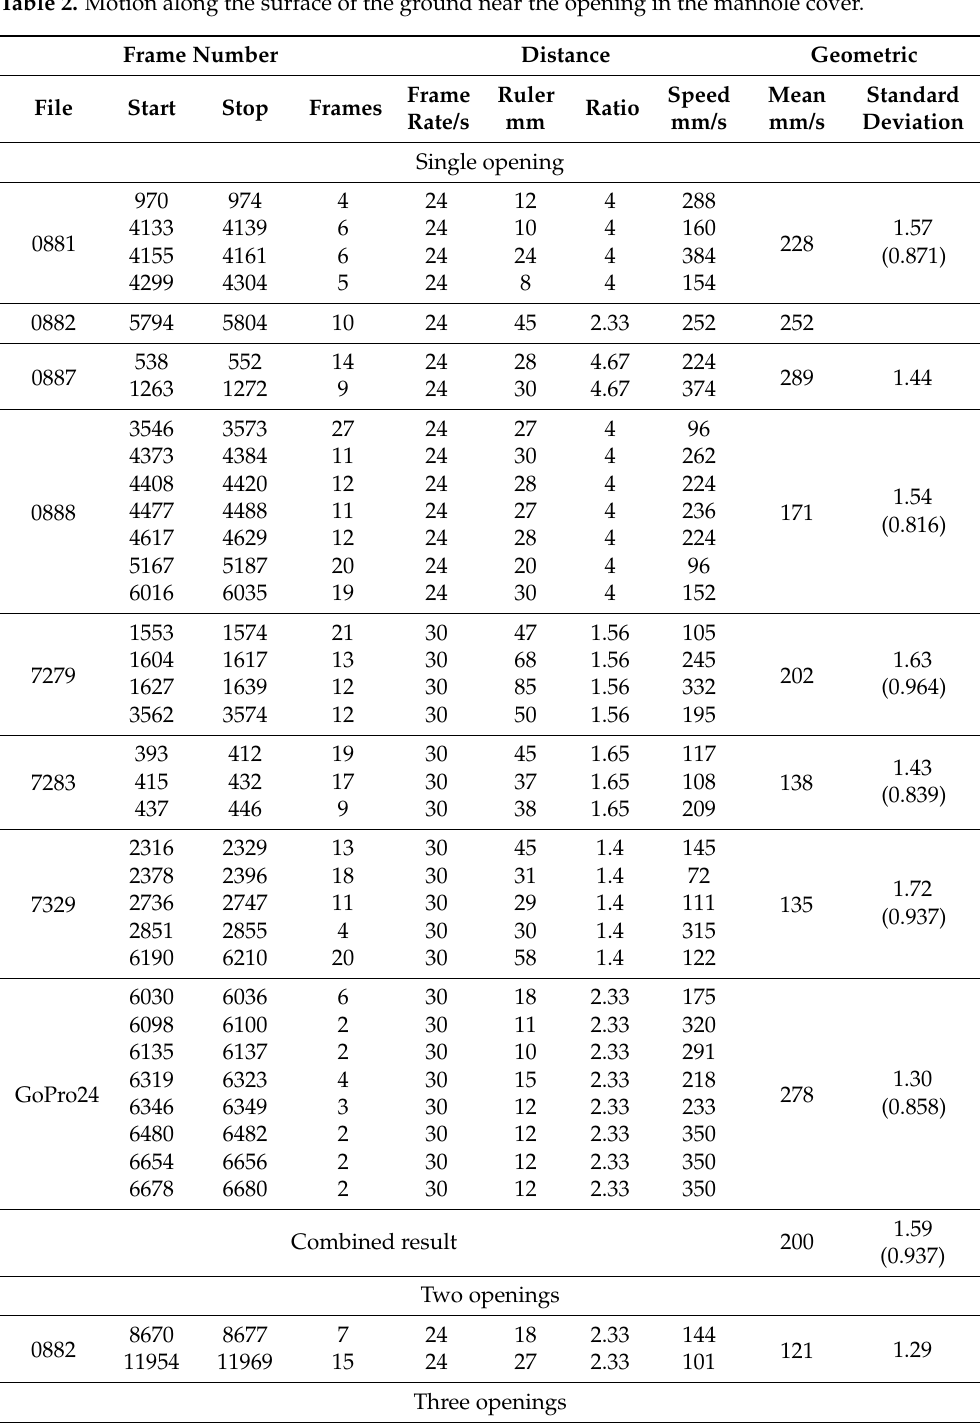
Table 2. Motion along the surface of the ground near the opening in the manhole